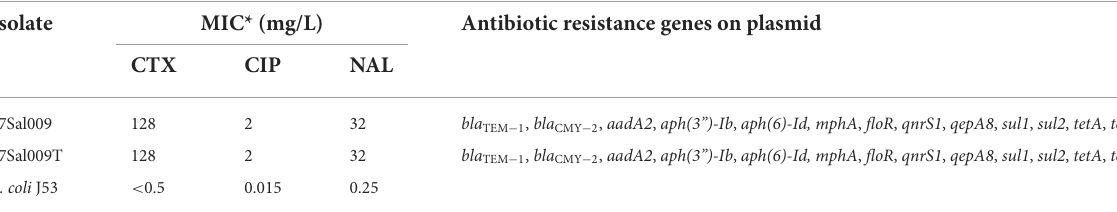
TABLE 1 The antimicrobial resistance profile and drug resistance genes of S. Thompson 17Sal009, the selected transformant (17Sal009T), and the recipient ( E.coli J53). Isolate